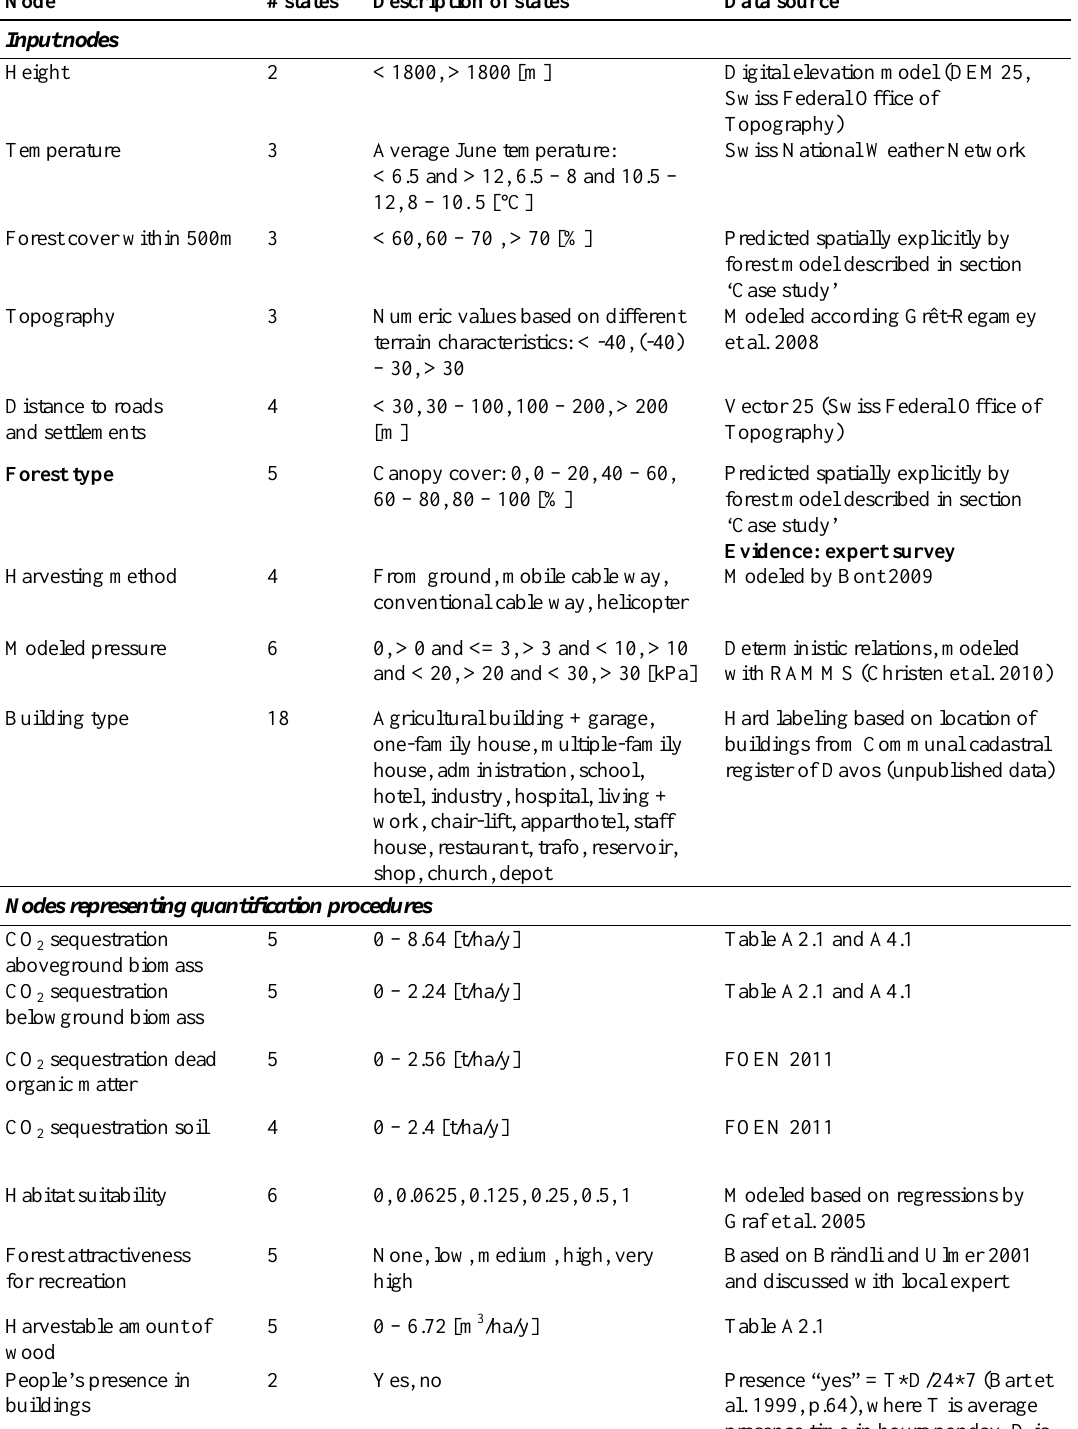
Table A1.1. States of the Bayesian network nodes, organized into the categories input nodes, nodes representing quantification procedures and nodes representing valuation procedures. Nodes that are updated by expert knowledge are